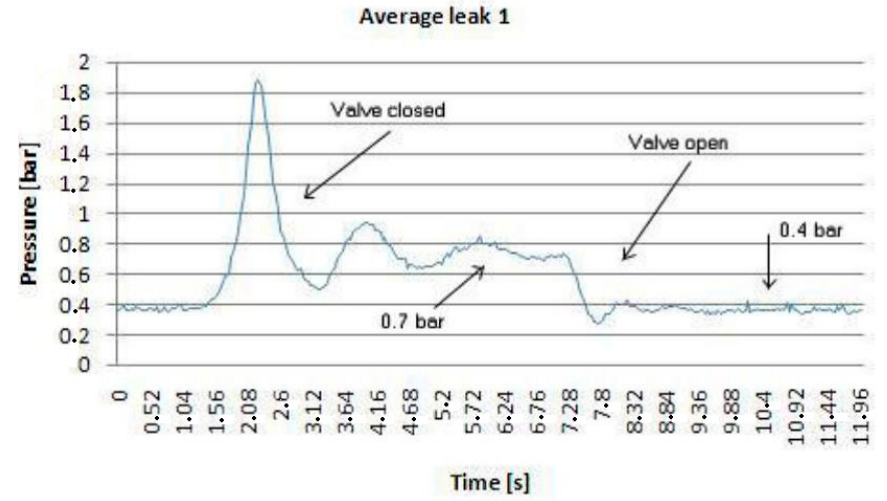
Figure 9. Correlation between different flow pressure trends by maneuvering water tap 1.